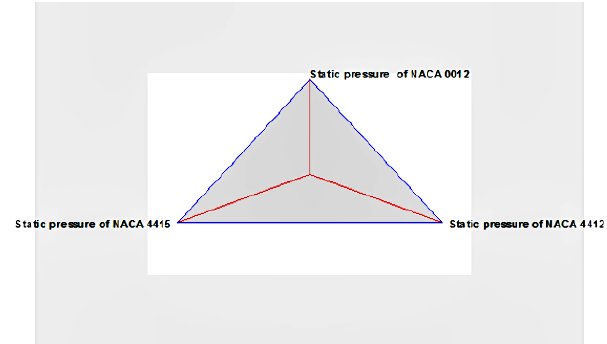
Figure 7. Turbulence intensity for three airfoils NACA 0012, NACA 4412, and NACA 4415.